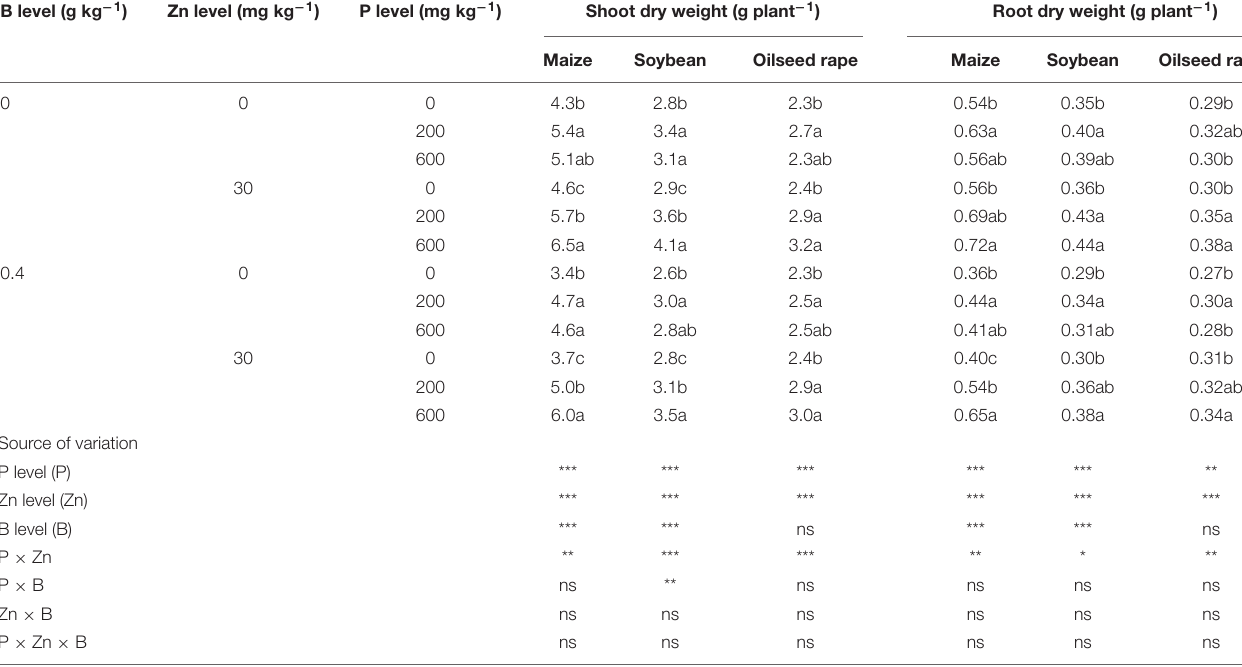
TABLE 1 | Shoot and root dry weights of maize, soybean, and oilseed rape affected by P application (P), Zn application (Zn), and benomyl addition (B), respectively. B level (g kg − 1